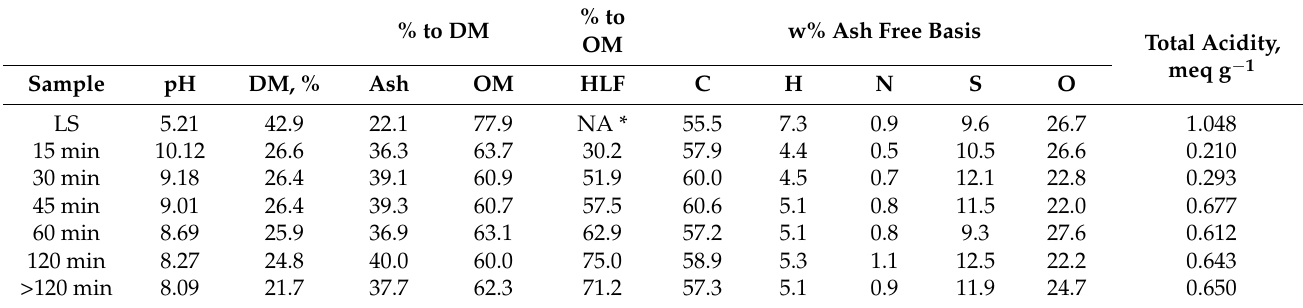
Table 1. Characterization of LH samples at different synthesis time.